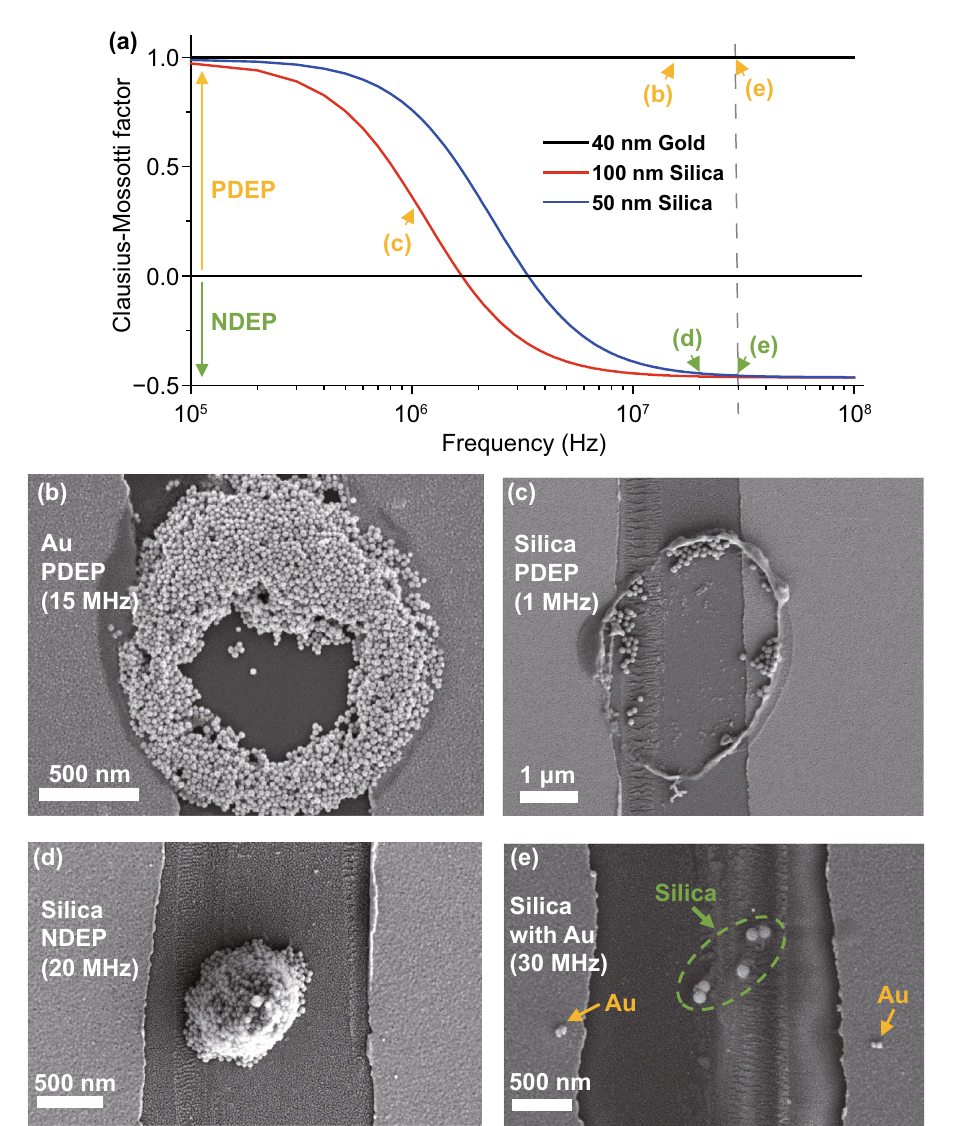
Fig. 3 SEM images of PDEP and NDEP experiments. a Clausius–Mossotti factor ( f 𝐂𝐌 ) of nanoparticles used for experiments. Several charac- teristics ( 𝛆 𝐦 ∕ 𝐩 , 𝛔 𝐦 ∕ 𝐩 , 𝛔 𝐛𝐮𝐥𝐤 , 𝐊 𝐬 ) of Au and silica nanoparticles are from reference [29]. The X-axis is a log scale of the frequency (Hz). Signs of f f 𝐂𝐌 change at ~2 MHz (100 nm silica), ~4 MHz (50 nm silica), and 𝐂𝐌 of 40 nm Au always has a plus sign in the 0.1–100 MHz range. Arrows show the frequencies used, and colors indicate PDEP (yellow) or NDEP (green). b PDEP result of Au nanoparticles with 40 nm diameter Au nanoparticles, ~2 µm diameter pipette with R 𝐢𝐧𝐧𝐞𝐫 ∕ R 𝐨𝐮𝐭𝐞𝐫 ratio = 0.7, V 𝐩𝐞𝐚𝐤 = 1.0 V, and 15 MHz frequency. Particles are attracted to surface electrodes of the substrate and the pipette. c PDEP result of silica nanoparticles with 100 nm diameter silica nanoparticles, ~ 2 µm diameter pipette, V 𝐩𝐞𝐚𝐤 = 2.5 V and 1 MHz frequency. Particles show the same tendency as in a . The concentration and surfactants of nanoparticle solu- tions result in differences between b and c. d NDEP result of silica nanoparticles with 50 nm diameter silica nanoparticles, ~1.5 µm diameter pipette, V 𝐩𝐞𝐚𝐤 = 2.5 V, and 20 MHz frequency. Particles move off to the surface electrodes of the substrate and pipette and gather around the center of the pipette. e Sorting result of the mixed solution with 100 nm diameter silica nanoparticles and 20 nm diameter Au nanoparticles, V = 2.5 V, and 30 MHz frequency. Silica nanoparticles in the green circle show NDEP and Au nanoparticles next to the yellow arrows 𝐩𝐞𝐚𝐤